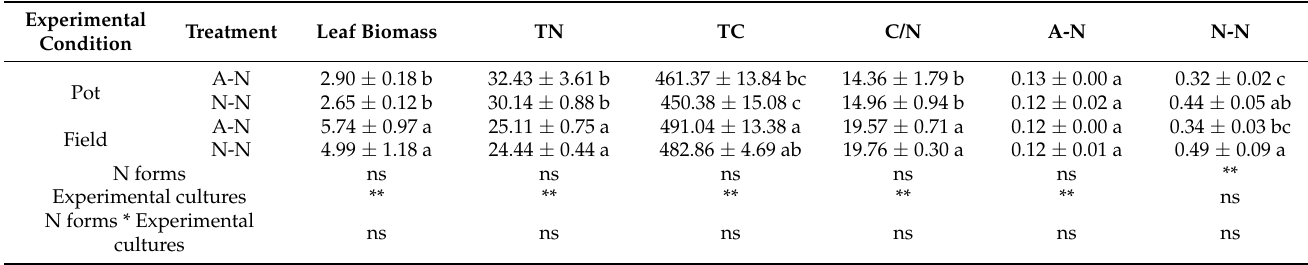
Table 1. Effect of different nitrogen forms on the biomass (g plant − 1 ), total nitrogen (TN, mg g − 1 DW) content, total carbon (TC, mg g − 1 DW) content, carbon–nitrogen ratio (C/N), ammonium nitrogen (A-N, mg g − 1 FW) content and nitrate nitrogen (N-N, mg g − 1 FW) content in stevia leaves.